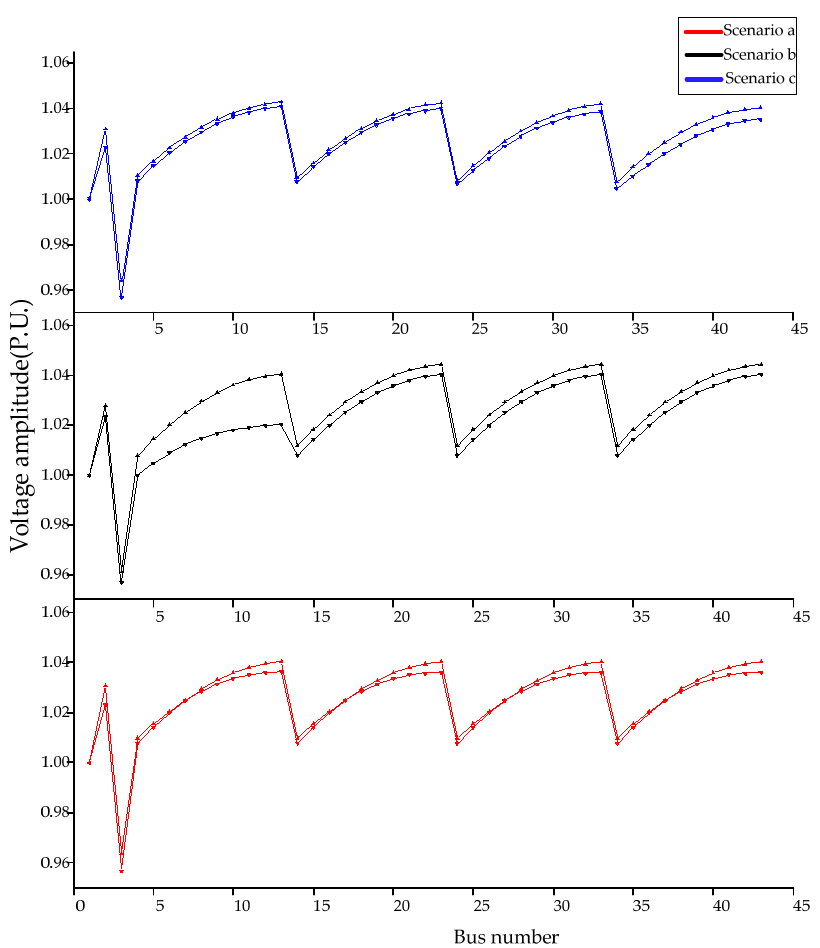
ff erent partial shading